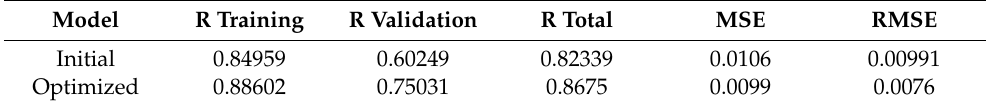
Figure 2. Relationship between the target and output values of the initial model.